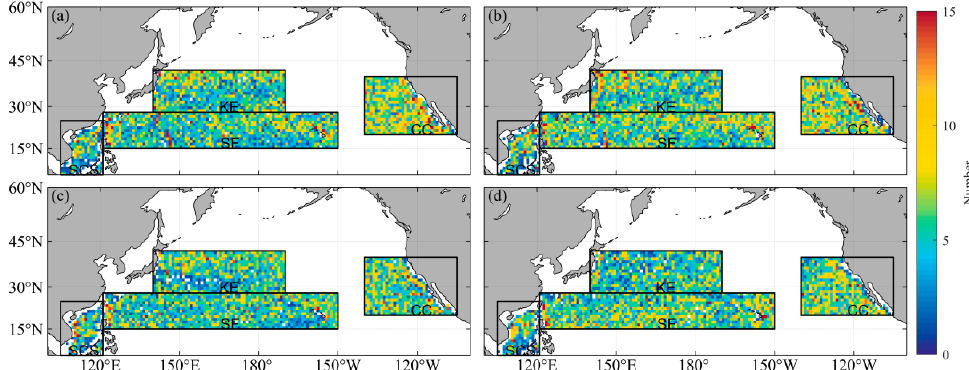
Figure 9. Number of eddy generation. AEs and CEs detected by the META dataset are given in ( a ) and ( b ), respectively. Identically, AEs and CEs detected by the GOMEAD dataset are given in ( c ) and ( d ), respectively.